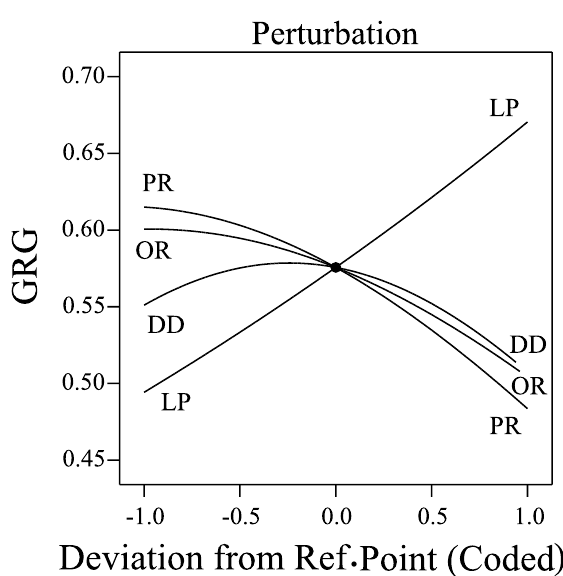
Figure 7. Effects of significant factors on GRG.